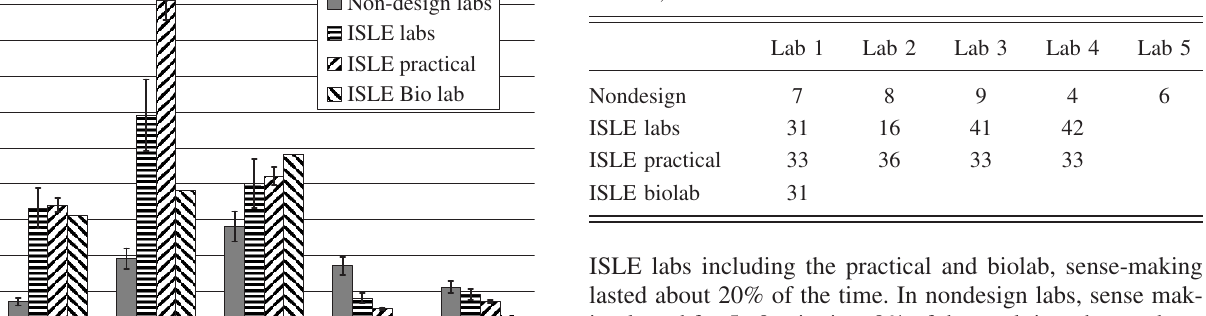
TABLE IV. Time spent on sense-making discussions (cid:1) in minutes (cid:2) .